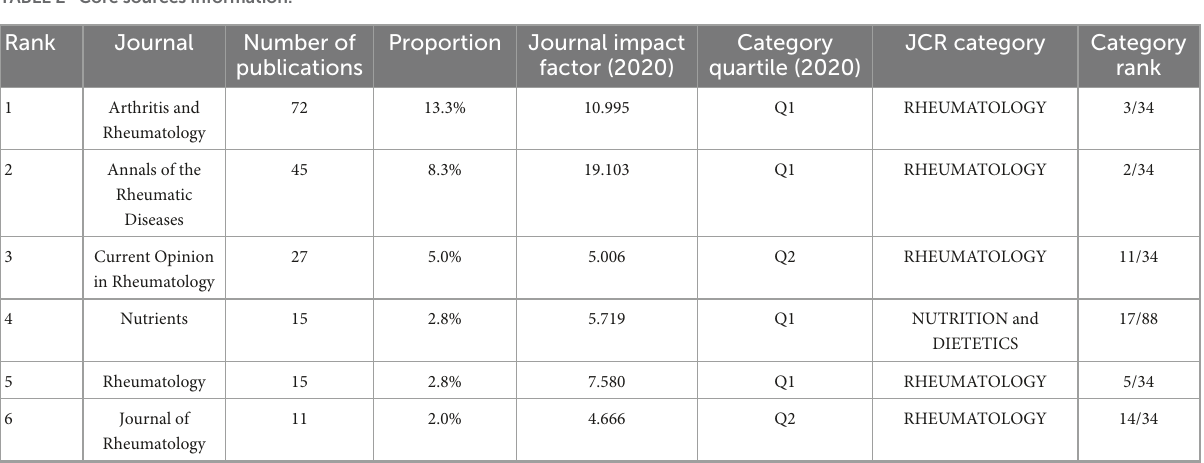
TABLE 2 Core sources